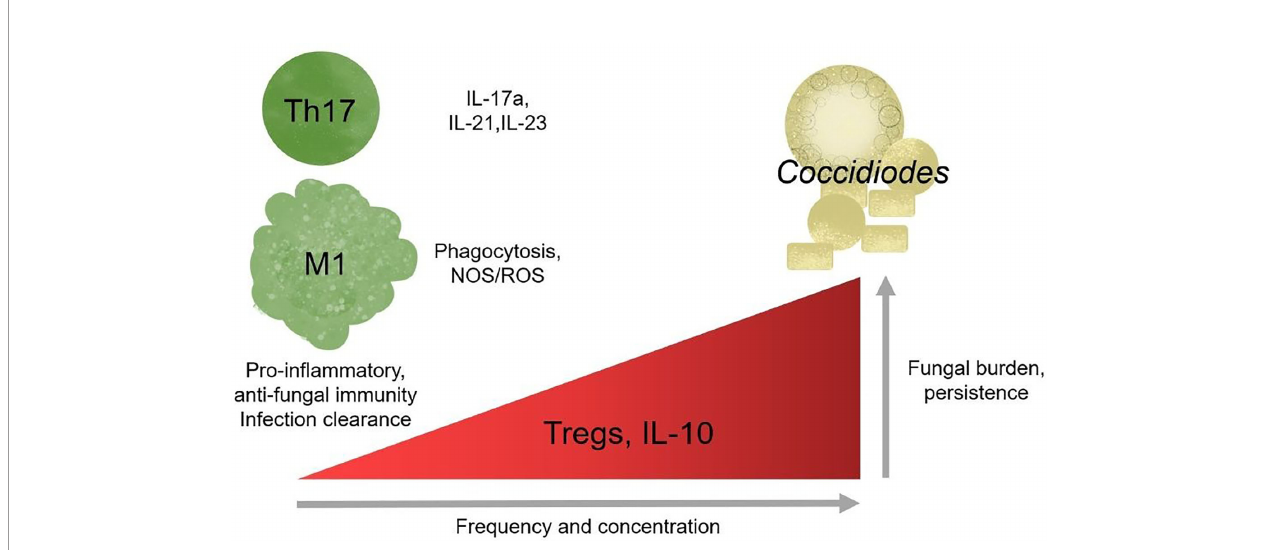
FIGURE 3 | Regulatory responses correlate with chronic disease outcome. Th17 cells and pro-in fl ammatory responses are protective against Coccidioides and loss of responses results in increase susceptibility in mice. Modulating effector and regulatory responses might be a potential therapy for chronic